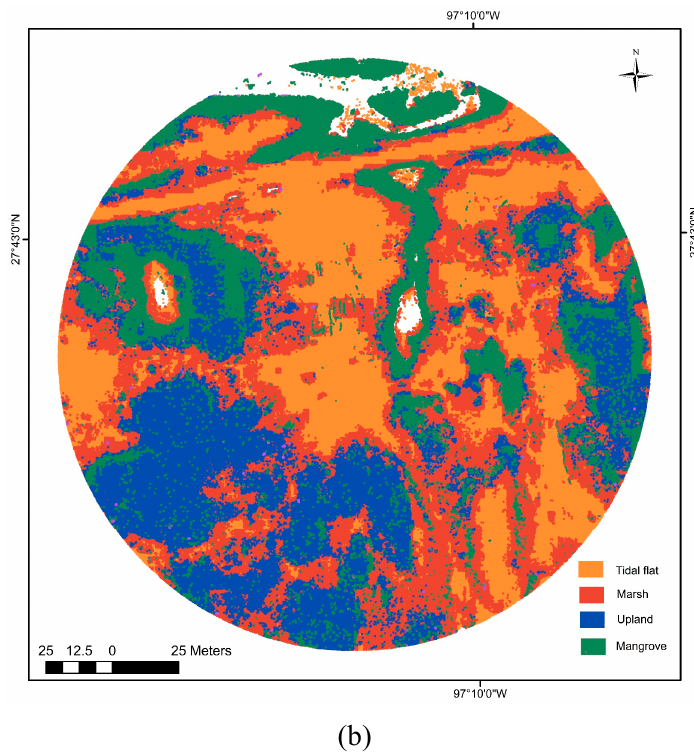
Figure 7. K-means clustering results of ( a ) TLS and ( b ) UAS-SfM point clouds. Colors represent the 4 different groups: tidal flat areas (orange), mangrove areas (green), upland areas (blue), low and high marshes (red). White areas show data gaps (areas with no points).